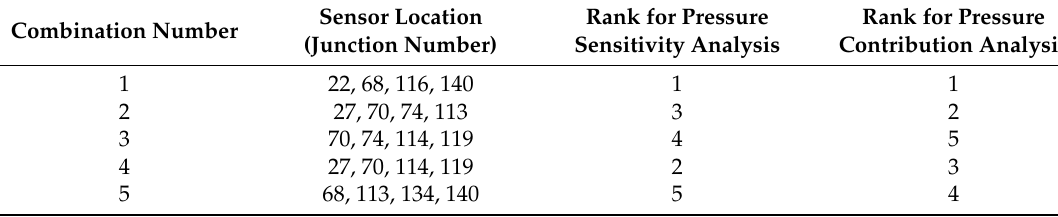
Table 11. Results of pressure contribution and sensitivity measurement.